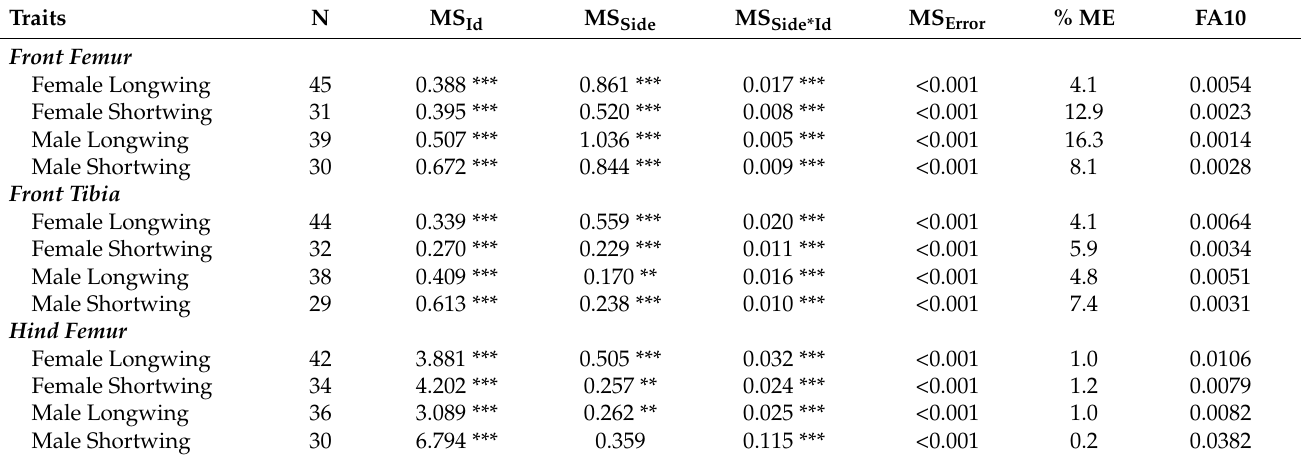
Figure 3. Boxplots comparing size across the eight univariate traits. Females and males are represented by blue and orange, respectively, whereas longwing and shortwing morphs are distinguished by dark and light shading. Plots of linear measurements are in mm; tympanum area is in mm 2 . Boxes enclose the median (centerline) and the 25th and 75th percentiles. Whiskers indicate the 10th and 90th percentiles. Significance levels of Tukey tests are indicated in Table S1. Table 1. Results of mixed-model two-factor ANOVAs. MS refers to ‘mean sum of squares’ for left-left comparison (Sides), individuals (Id), and their interaction term